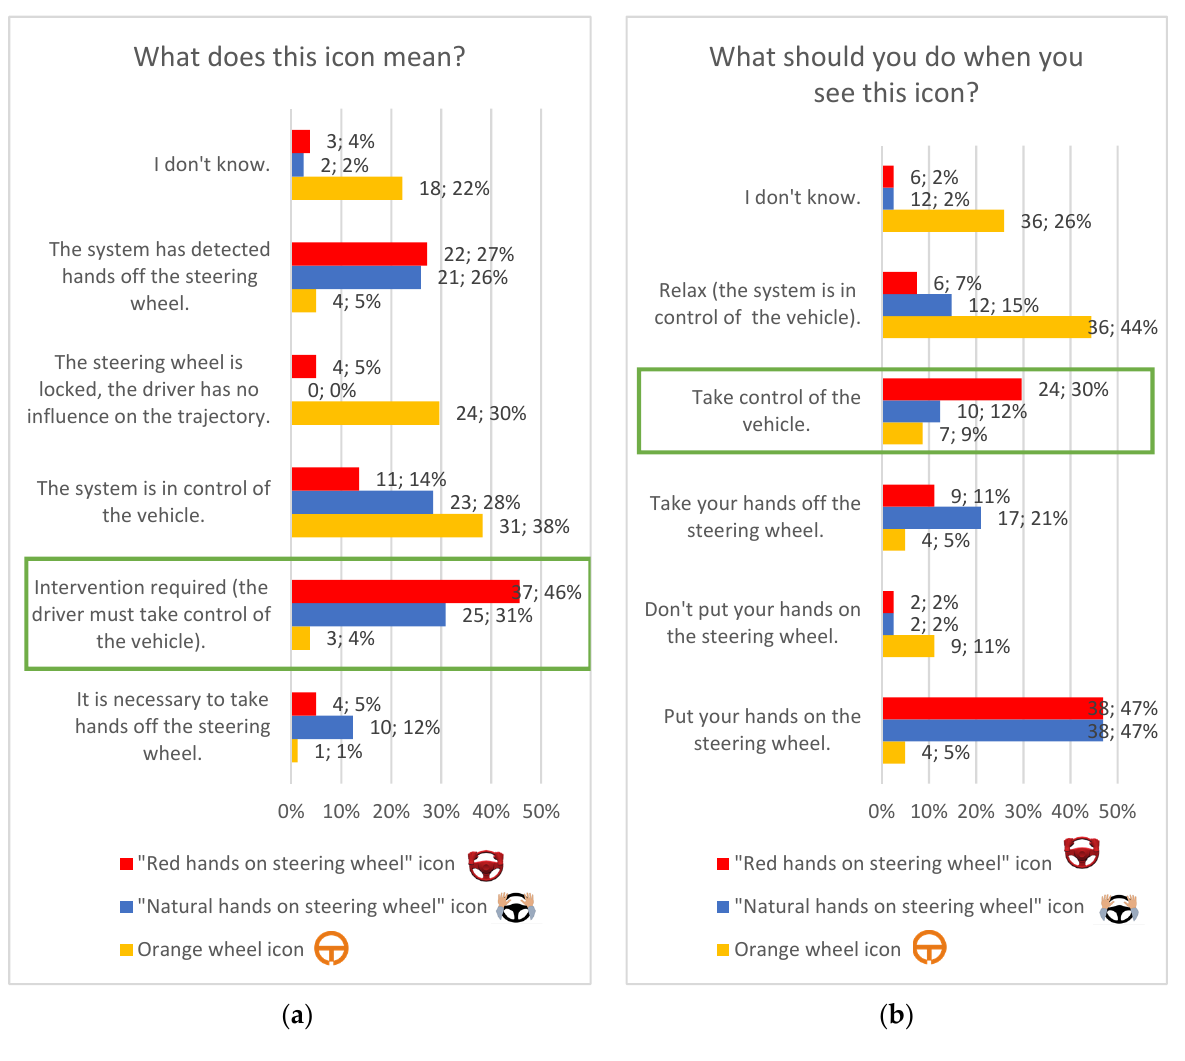
Figure 3. Comprehension Test, assessing the comprehension of the message conveyed by the icons: ( a ) What does this icon mean? ( b ) What should you do when you see this icon? The correct answer is marked with a green rectangle. ITS icons